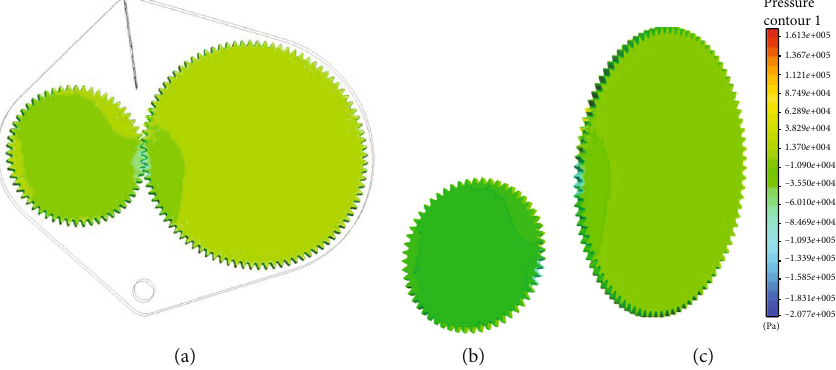
Figure 8: Pressure distribution nephogram of gear pair (a) the gear pairs, (b) the pinion, and (c) the